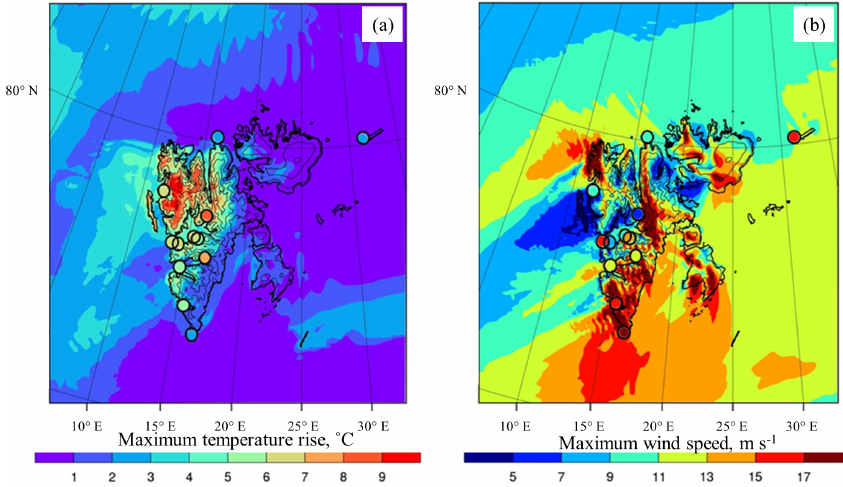
Figure 5. Maximum temperature rise at 2ma.g.l. (see explanations in the text) (a) and maximum wind speed at 10ma.g.l. (b) during the foehn episode according to modeling and observations at weather stations